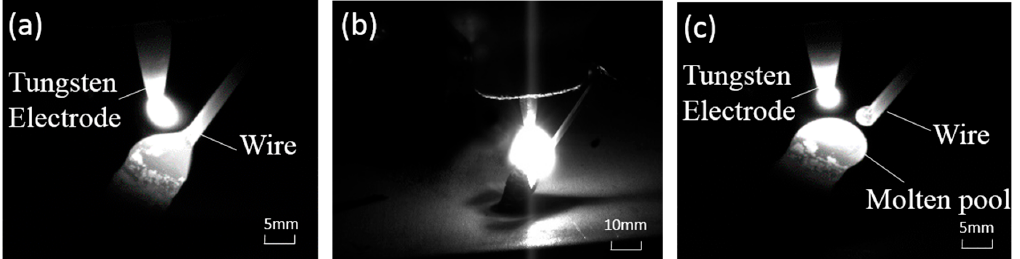
Figure 4. Actual image of layer accumulation. ( a )wire feeding; ( b )peak time; ( c )completing the transition.